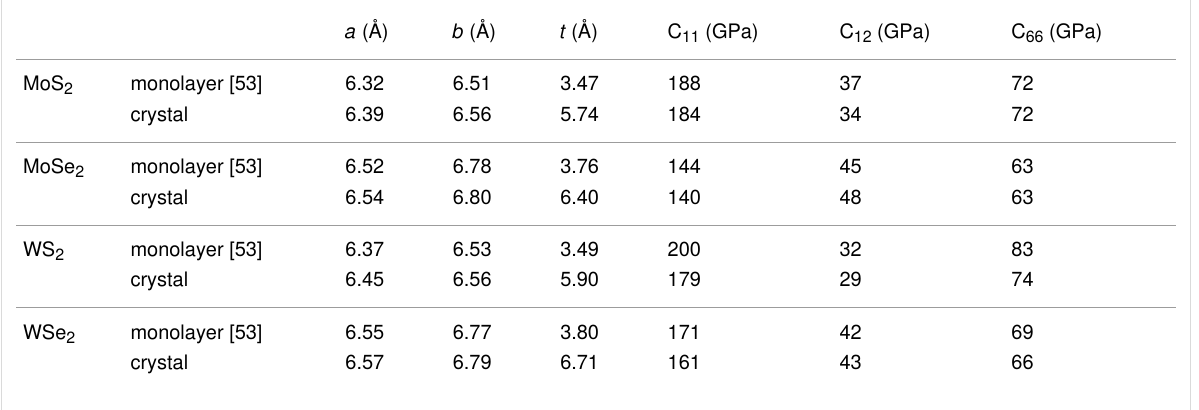
Table 3: Calculated lattice constants a (Å), b (Å), and elastic constants of 1T ′ TMD monolayer and crystal.